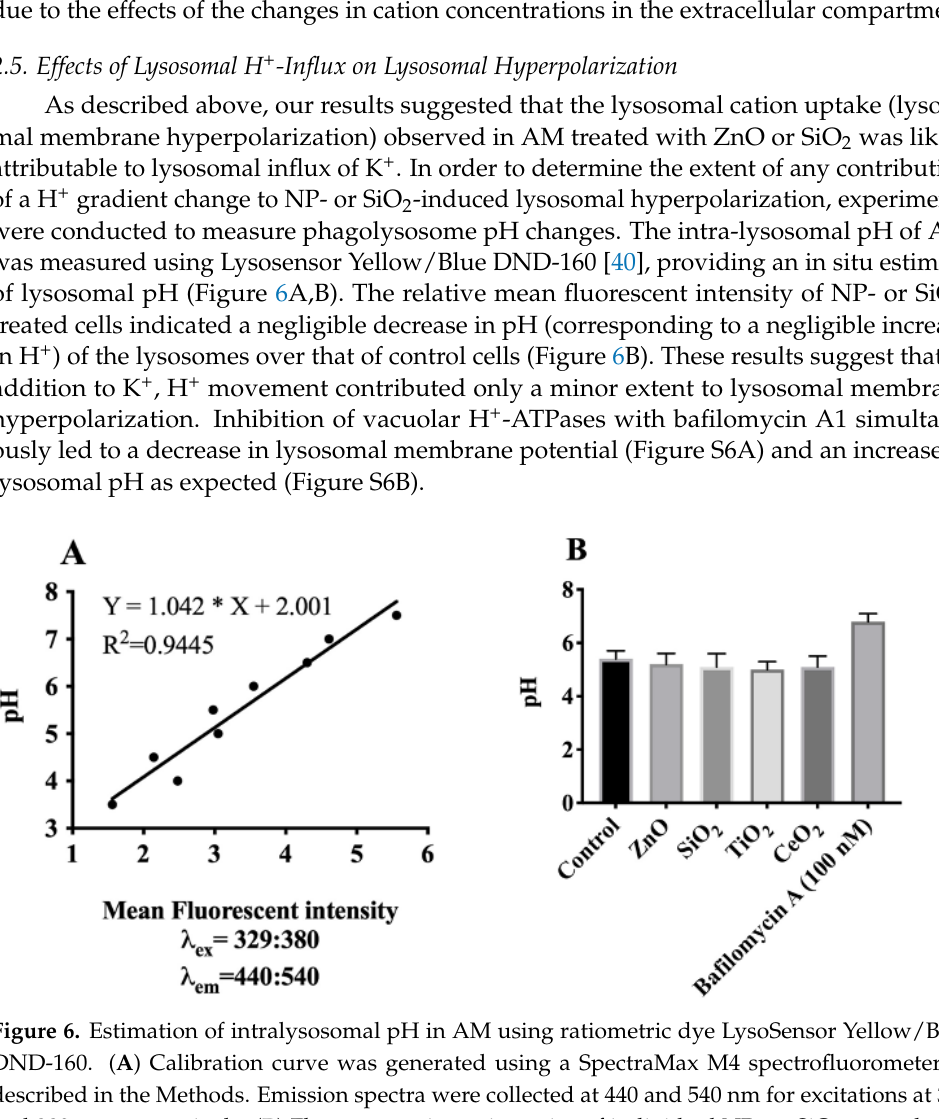
-treated cells 2